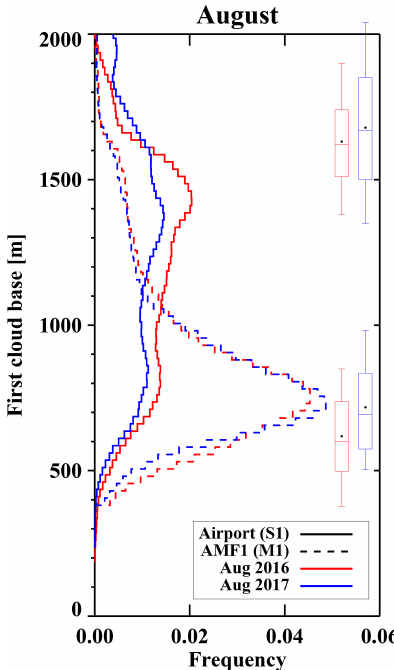
Figure 2. Normalized frequency distribution of the lowest ceilometer-derived cloud bases in August 2016 (red) and 2017 (blue) at the airport (solid) and AMF1 site (dashed). The me- dian, 10th, 25th, 75th and 90th percentile values of the radiosonde- derived lifting condensation level and trade-wind inversion base are indicated for both years, with filled circles indicating the